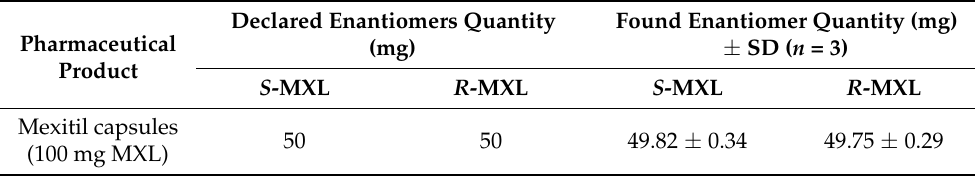
Table 6. MXL enantioselective determination from pharmaceutical